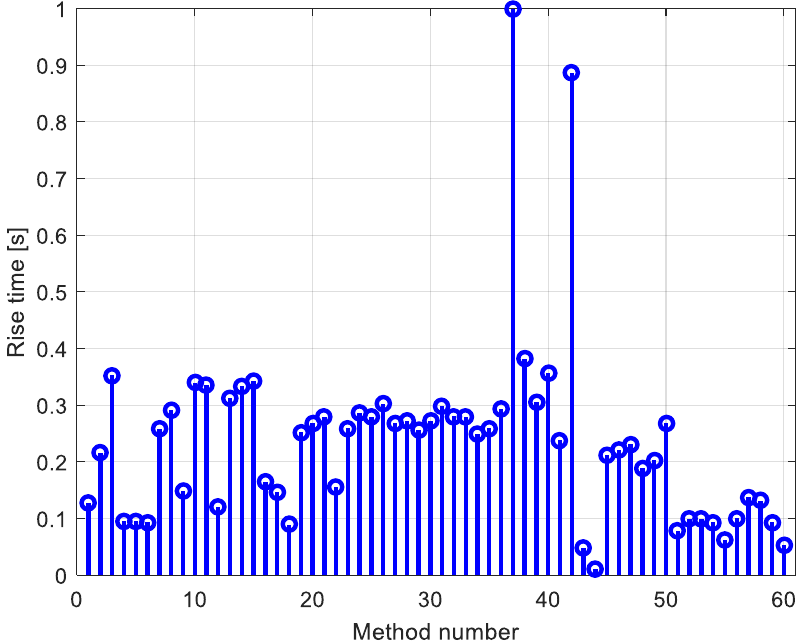
Figure 2. Rise time of the generator voltage for the different methods presented in Table 1.